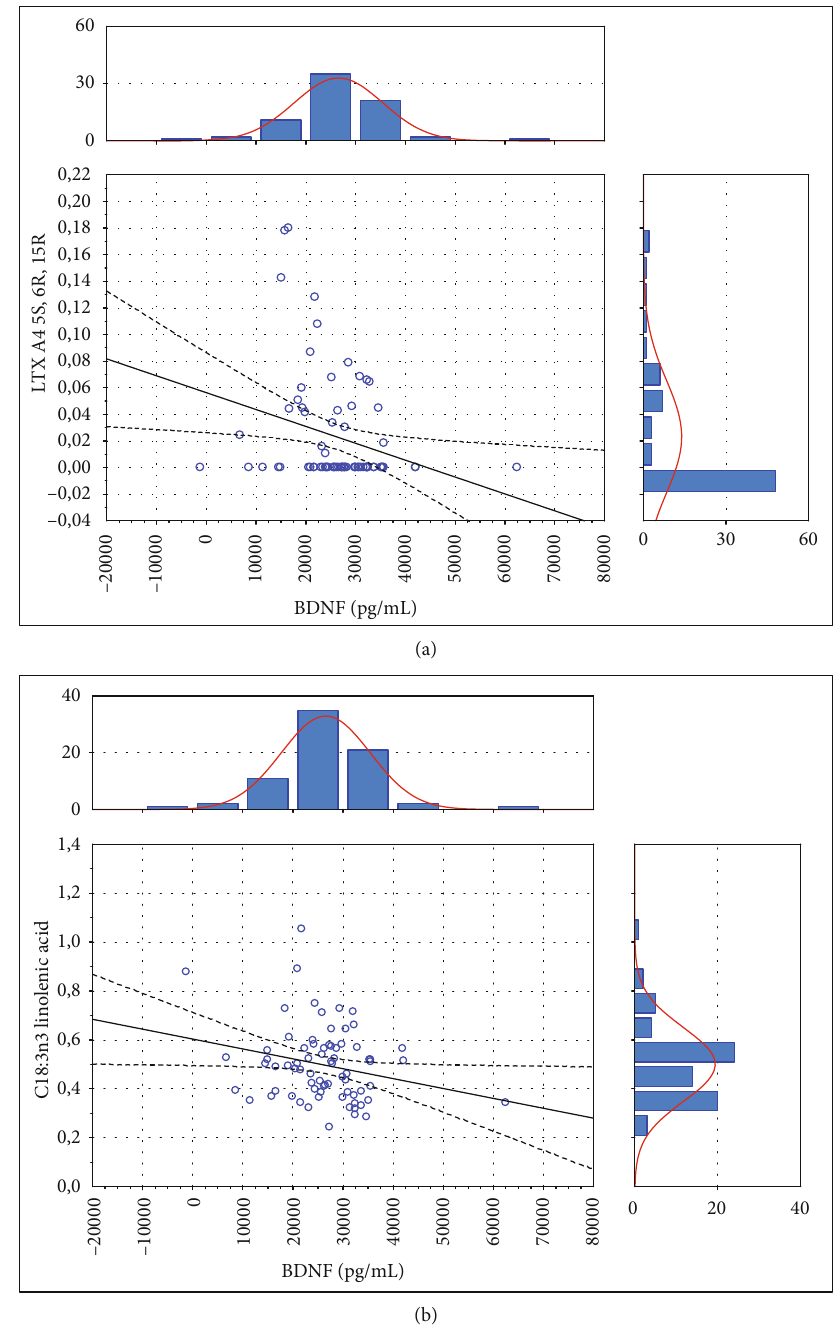
Figure 2: The relationship between (a) BDNF and lipoxin A4 15-epi-LxA4 A4 5S, 6R, 15R ( r = − 0 : 238 , p < 0 : 05 C18:3n3 linolenic acid ( r s